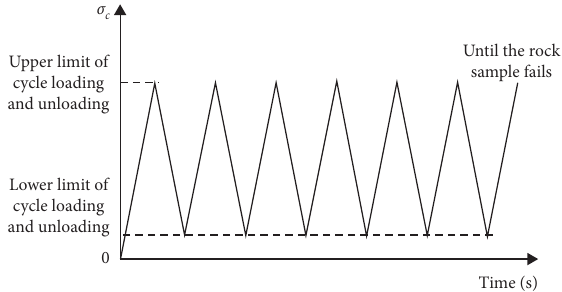
Figure 11: Stable cyclic loading and unloading